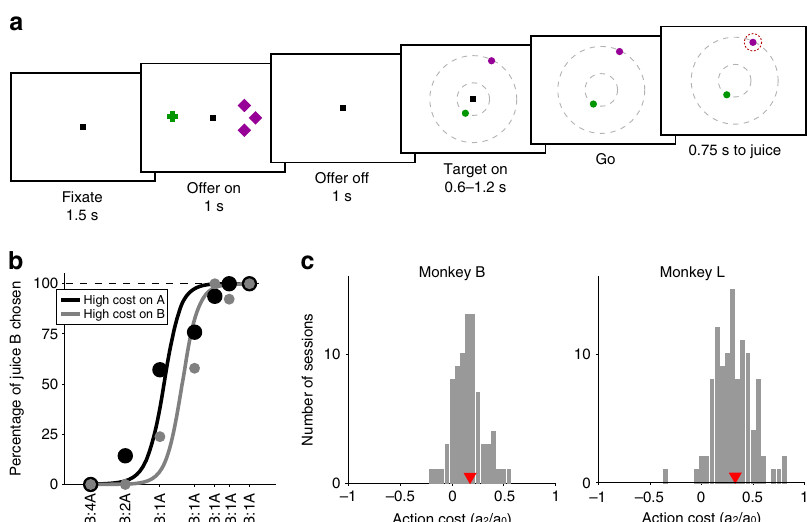
Fig. 1 Experimental design and behavioral analysis. a At the beginning of the trial, the monkey fi xated a center point on the monitor. After 1.5 s, two offers appeared to the left and right of the fi xation point. The offers were represented by sets of color symbols, with the color indicating the juice type, the number of squares indicating juice amount and the shape of the symbols indicating the action cost associated with the offer (crosses, low cost; diamonds high cost). The offers remained on the monitor for 1 s, then disappeared. The monkey continued fi xating the center point for another 1 s. At the end of this delay, two saccade targets (two color dots) appeared. The two saccade targets were located on two (invisible) concentric rings centered on the fi xation point. The monkey maintained fi xation for a randomly variable delay (0.6 – 1.2 s) before the center fi xation point was extinguished (go signal), at which point the monkey indicated its choice with a saccade. Importantly, the association between the symbols (cross, diamond) and the saccade amplitudes (short, long) was known to the monkey. b Choice patterns, one session. The percentage of B choices is plotted against the ratio #B:#A, where #A and #B are quantities of juice A and B, respectively. Trials were separated in two groups depending on the action cost for juice A. The choice pattern obtained when juice A had a high cost (black) was displaced to the left (lower indifference point) compared with the choice pattern obtained when juice A had a low cost (gray). The regression lines were obtained with a simpli fi ed version of Eq. (1) in which terms a 3 to a 6 were removed. The action cost can be measured as ξ = a 2 / a 0 (Eq. 1). c Distribution of action costs measured across sessions for monkey B (79 sessions, median( ξ ) = 0.174, p < 10 − 10 , Wilcoxon signed-rank test) and for monkey L (107 sessions, median( ξ ) = 0.327, p < 10 − 10 , Wilcoxon signed-rank test). Red triangles indicate median